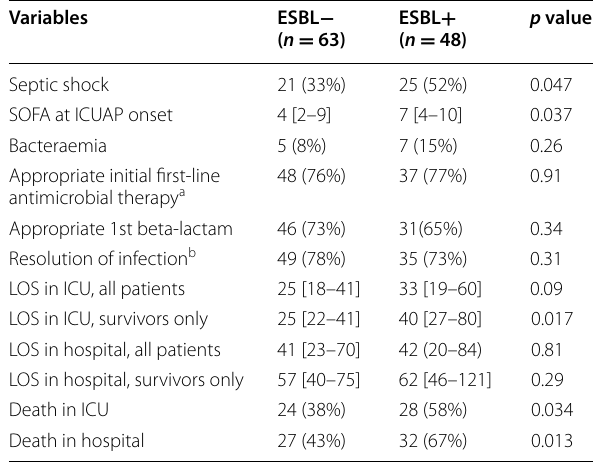
Table 2 Outcome associated with nosocomial pneumonia, according to aetiology ( n =